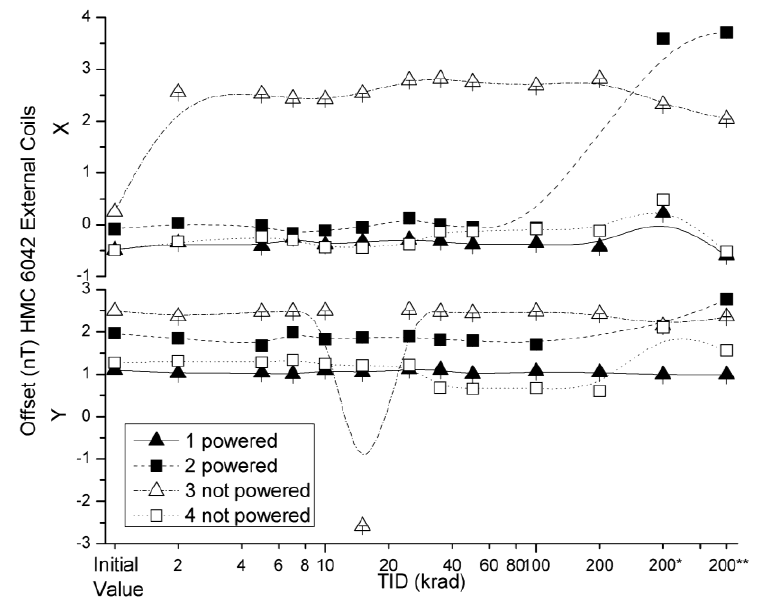
Figure 11. Measured offsets in external coils configuration as a function of TID for powered and non-powered HMC 6042.